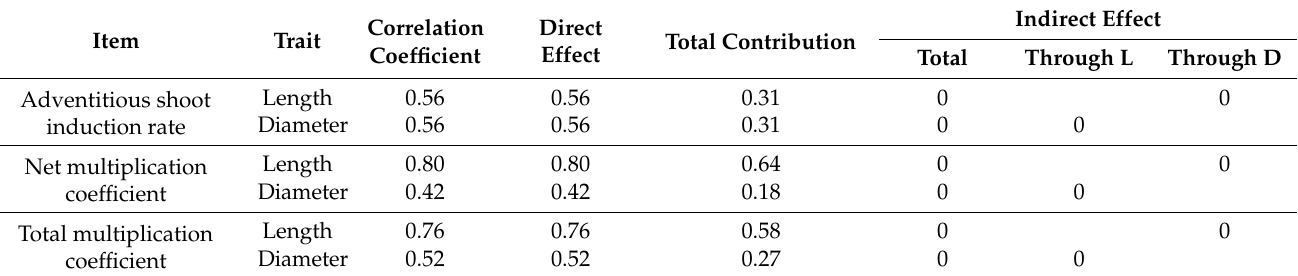
Table 3. Path analysis of roots’ length and roots’ diameter in root budding.